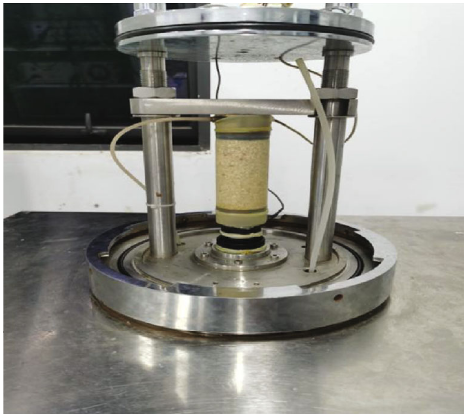
Figure 3: Calcareous sand sample